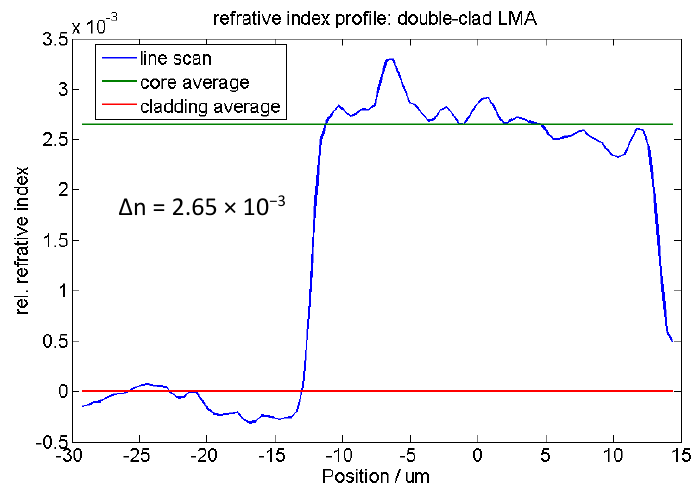
Figure 16. Reflection-based refractive index mapping method [41]: refractive index profile of the double-clad fiber with a Δn of 2.65 × 10 -3 [7].